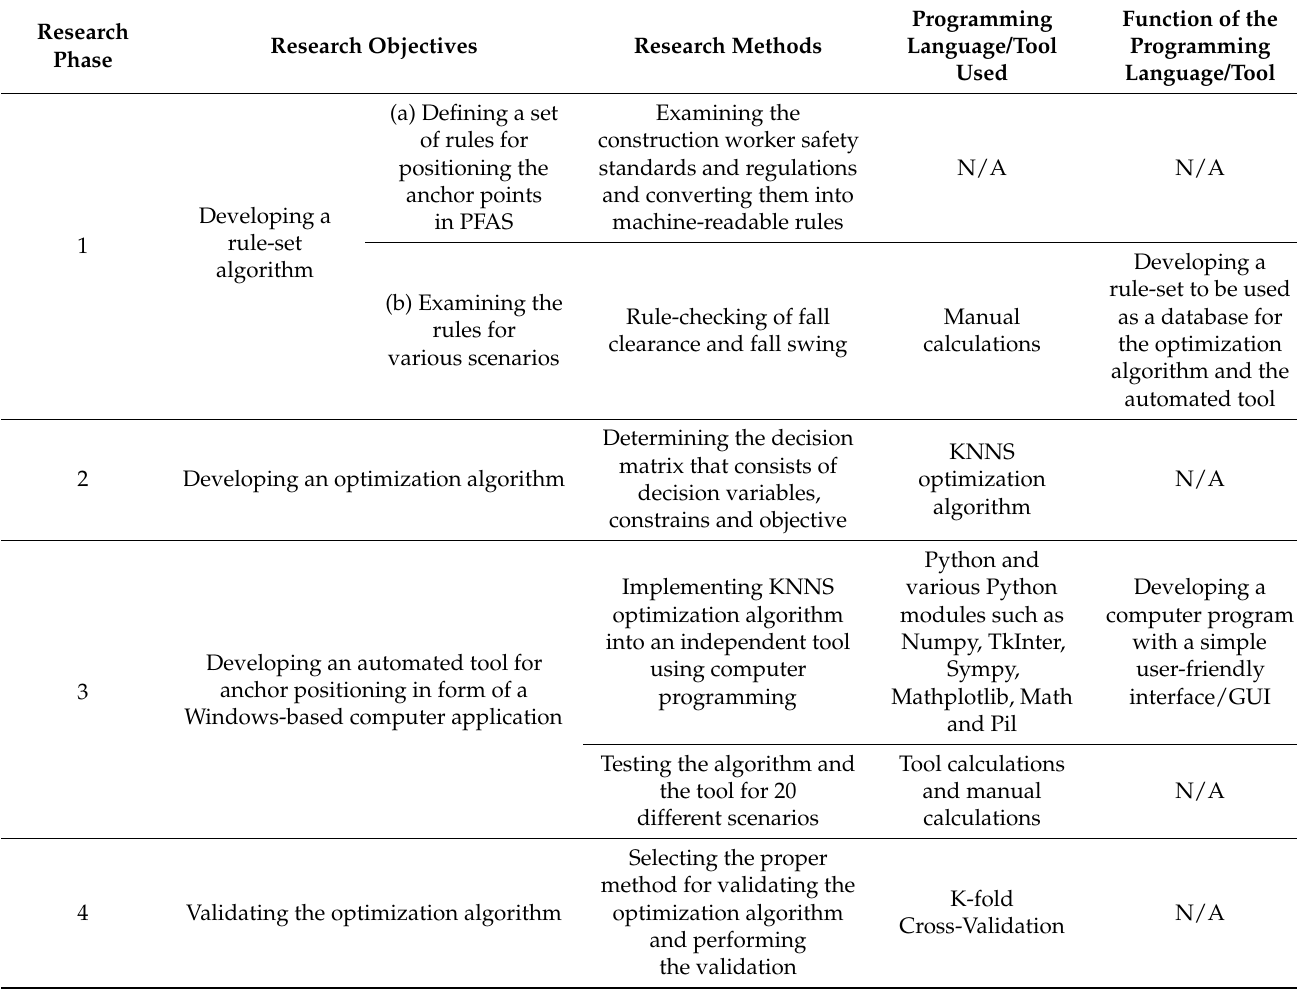
Table 1. Research objectives and